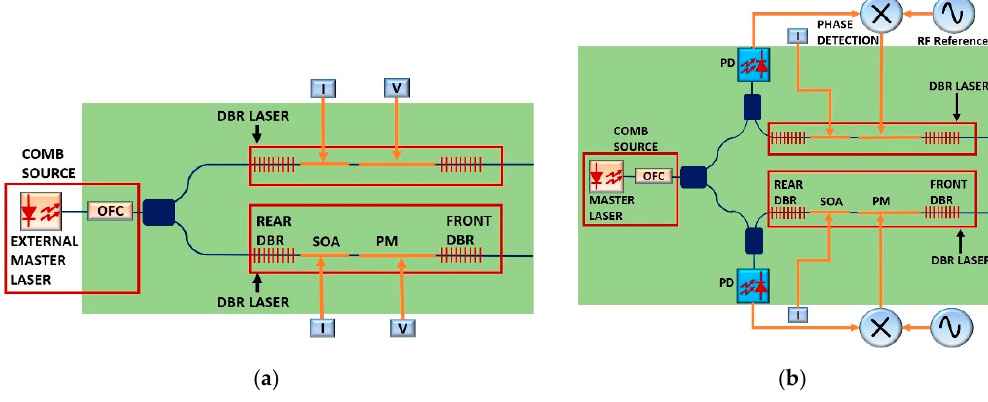
Figure 5. ( a ) Scheme of a photonic integrated version of the optical injection locking technique, ( b ) Scheme of an Optical Phase Locked Loop. The slave DBR lasers are used to lock one of the comb lines of the Optical Frequency Comb (OFC). The integrated DBR lasers can tune the wavelength by varying the current I on the SOA and the voltage V on the PM. The PDs on the OPLL are used to mix the master and slave beams to detect in the electrical domain the phase di ff erence. The rear and front DBR are made of